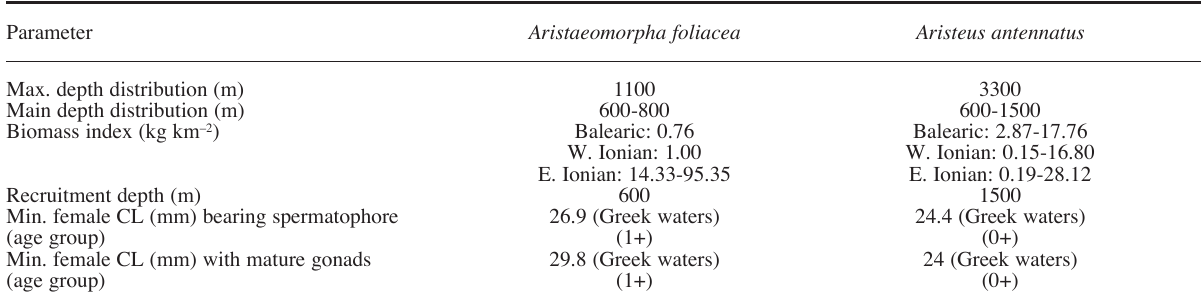
T ABLE 8. – Comparison of parameters obtained for Aristaeomorpha foliacea (present work) and Aristeus antennatus (Sardà et al. , 2001)